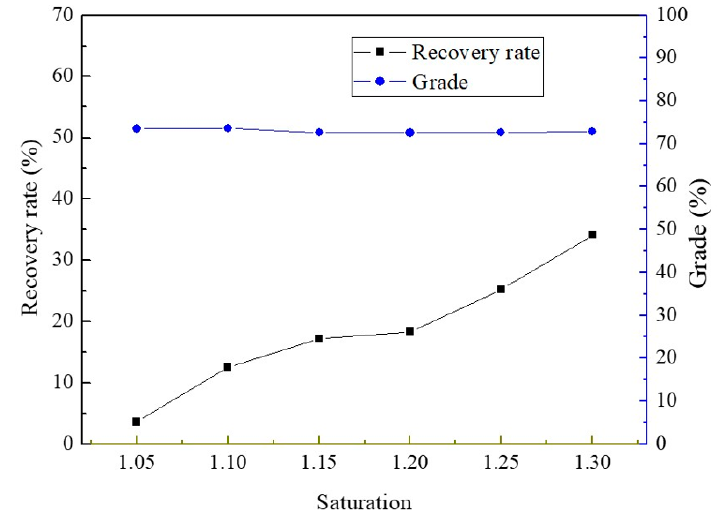
Figure 8. Recovery rate and grade of crystals produced by the MD integrated with crystallization process at different saturations.